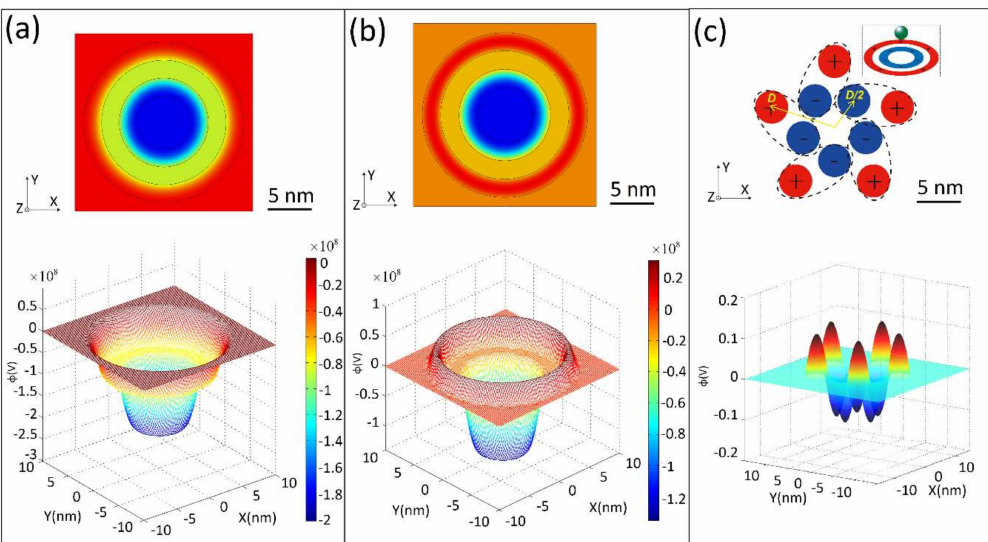
Figure 1. Electric potential distributions were generated by di ff erent charge distributions at the nanoscale. ( a ) Continuous charge distribution in a double-ring structure, where the inner ring (negative charged) and outer ring (positive charged) exhibit the same charge quantity of 100 charges. ( b ) Continuous charge distribution of the same double-ring structure, where both rings exhibit the charge density but opposite sign: Positive for outer ring and negative for inner ring. ( c ) Discrete charge distribution of five dipoles arranged in a nano-pentagon